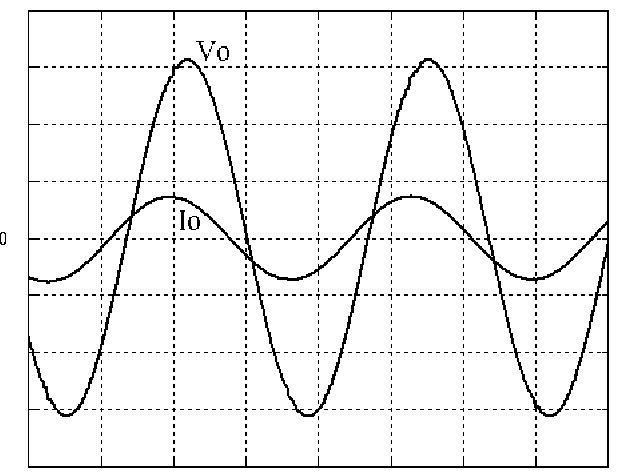
Figure 10. Simulated output waveforms with conventional RSMC at capacitive load (vertical: 100 V/div and 20 A/div; horizontal: 5 ms/div).